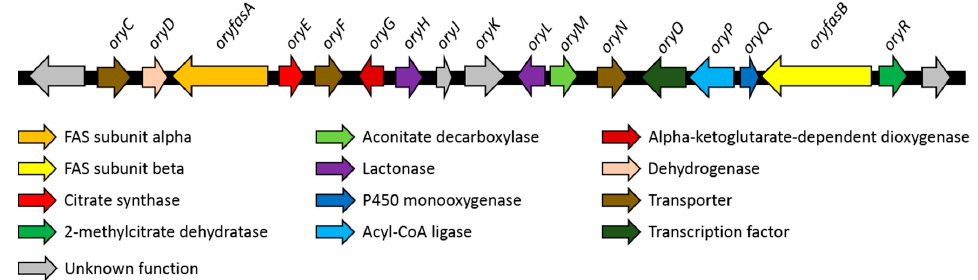
Figure 3. Putative biosynthetic gene cluster of the oryzines.